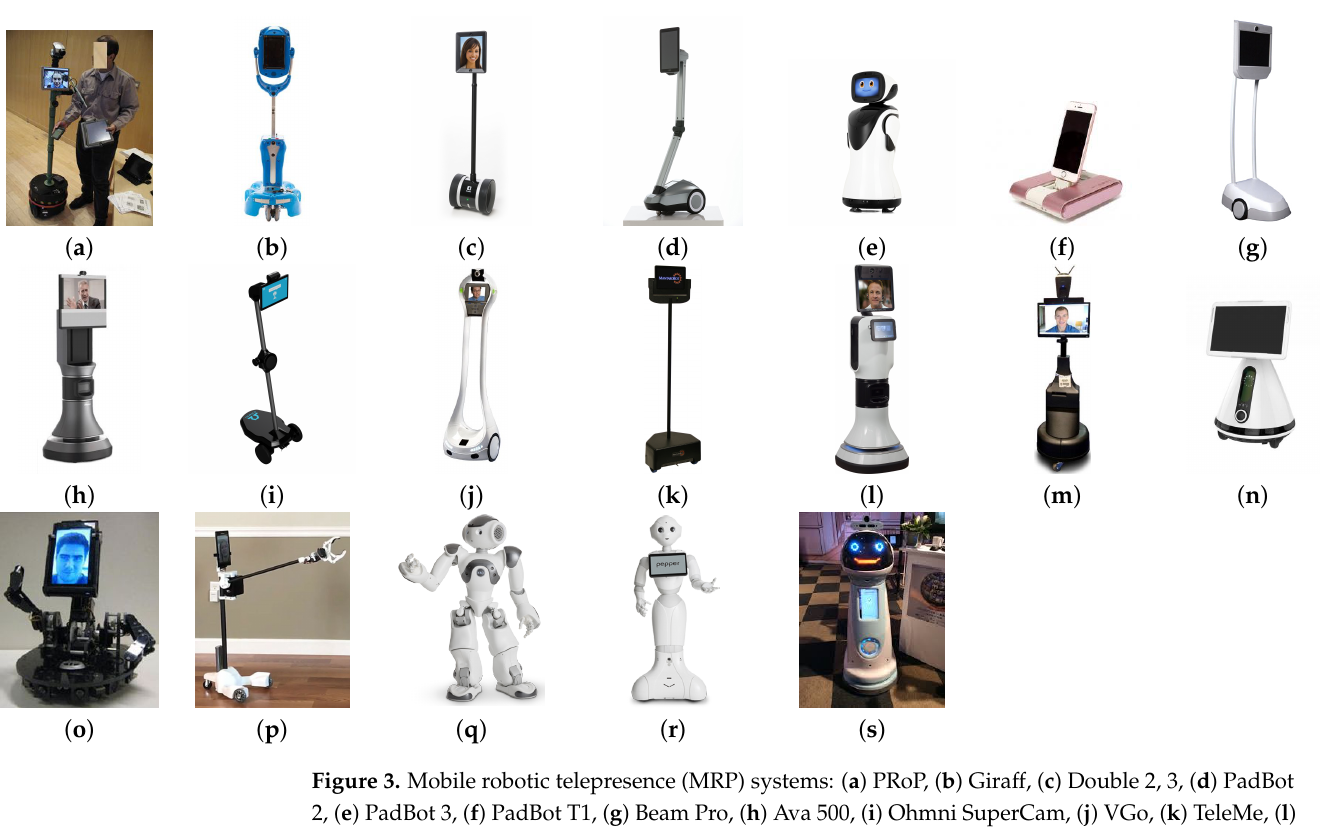
Figure 3. Mobile robotic telepresence (MRP) systems: ( a ) PRoP, ( b ) Giraff, ( c ) Double 2, 3, ( d ) PadBot 2, ( e ) PadBot 3, ( f ) PadBot T1, ( g ) Beam Pro, ( h ) Ava 500, ( i ) Ohmni SuperCam, ( j ) VGo, ( k ) TeleMe, ( l )